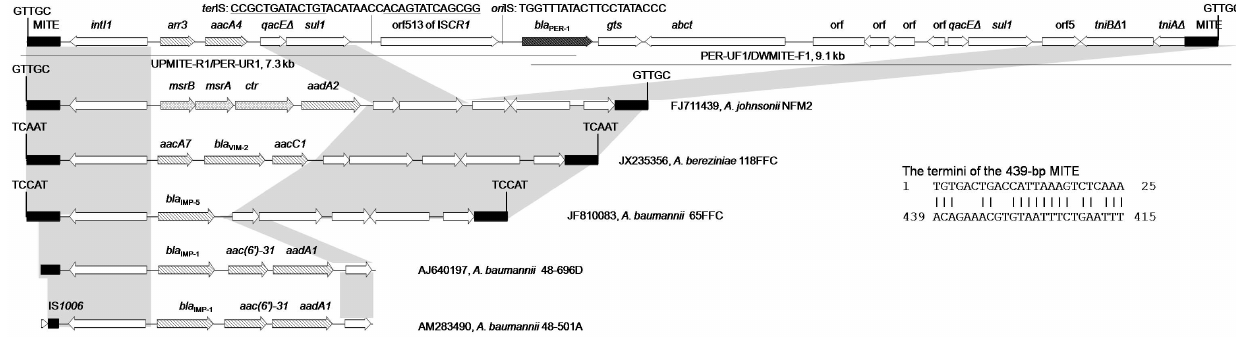
Figure 1. Structures flanked by the 439-bp MITE. Two overlapping long-range PCR are shown by lines with primer names and amplicon sizes being indicated. The MITEs shown here have identical nucleotide sequences and are in the same direction. The 5-bp DR characteristics of the transposition of MITE-form composite transposon-like element are indicated. The GenBank accession numbers, the host species and strain number of each structure are listed. The identical regions are highlighted in grey. Only partial sequences are available for the integron carrying bla IMP-1 (GenBank accession numbers AM283490 and AJ640197). The ori IS and the putative ter IS of IS CR1 are shown and the inverted repeats of ter IS [23] are underlined. The 25-bp terminal sequences of this 439-bp MITE are shown with 18 bp